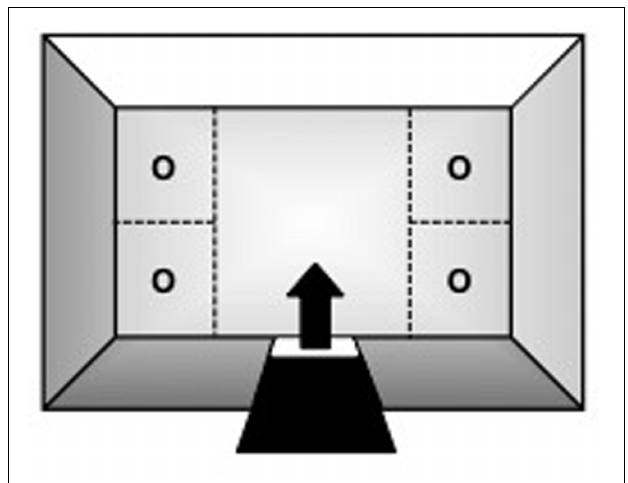
FIGURE 1 | Top-view schematic representation of the marmoset open field apparatus, indicating the subjects’ entry/exit point (arrow) via the guillotine-type door, the four corner sections where stimuli could be placed during specific trials of the procedure (O), and the larger central zone.